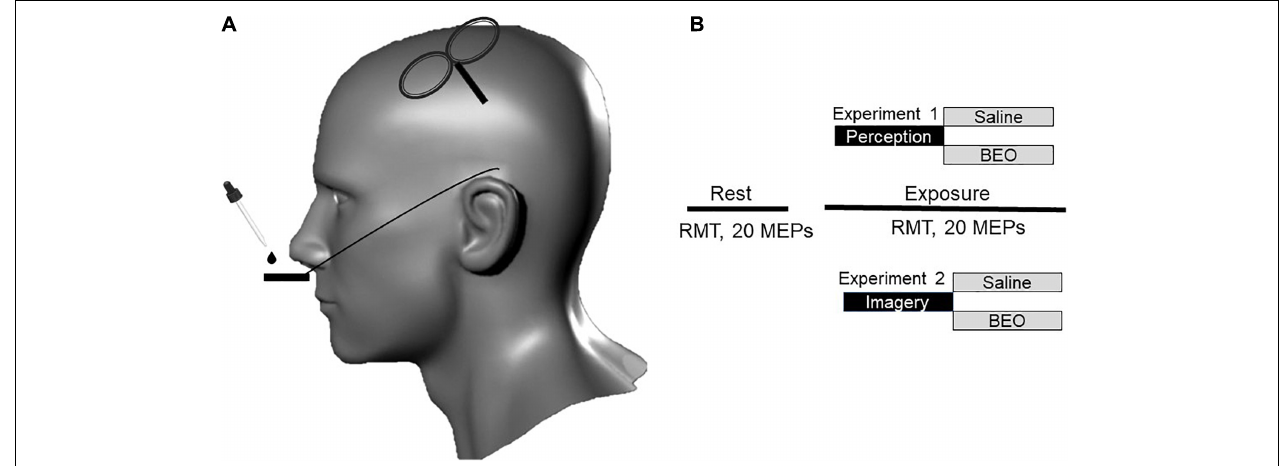
FIGURE 1 | Study design and experimental procedure. (A) Transcranial magnetic stimulation (TMS) stimuli were delivered over the left motor cortex. Olfactory stimulation was carried out by using paper strips soddened with Bergamot essential oil (BEO) or with saline. (B) In experiment 1 (perception), the participants were asked to inhale two drops of bergamot essential oil of saline positioned on a paper located on metal holder below the nose. The two interventions were randomized and separated by a 2-h break. During experiment 2 (Odor imagery), the participant was asked to mentally rehearse (odor imagery) the two conditions experienced the in the previous day. At rest, we recorded resting motor threshold (RMT) and twenty motor evoked potentials (MEPs). The same parameters were tested during the continuous exposure/imagery of BEO/saline. TABLE 1 | Mean ± SD scores for pleasantness of bergamot essential oil (BEO) perception, vividness of olfactory imagery questionnaire (VOIQ), vividness of BEO olfactory imagery (OI), and Big 5 personality dimensions. Pleasantness of BEO VOIQ score Vividness of BEO